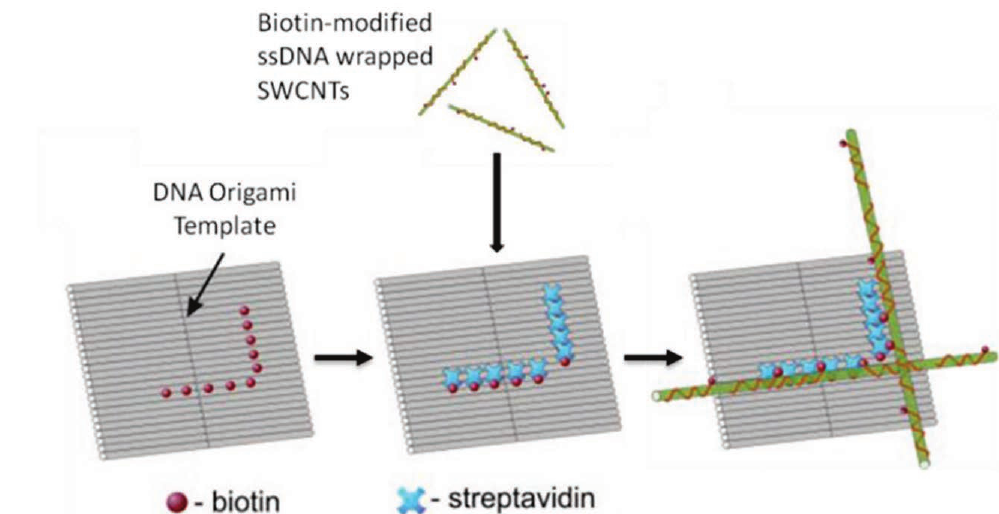
Figure 4. Schematic diagram of SWCNT assembly on DNA origami templates using streptavidin-biotin interaction. Reprinted with permission from [38 ]. Copyright 2011 WILEY-VCH [